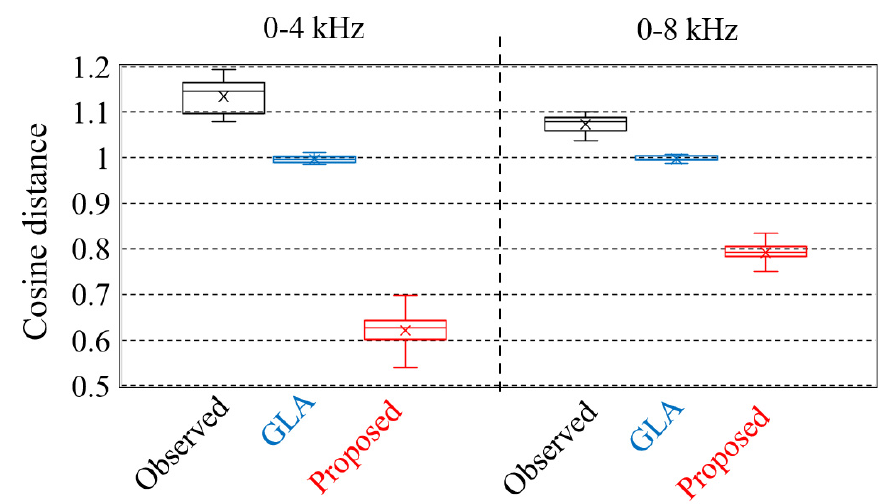
Figure 12. Cosine distance of reconstructed phases with each